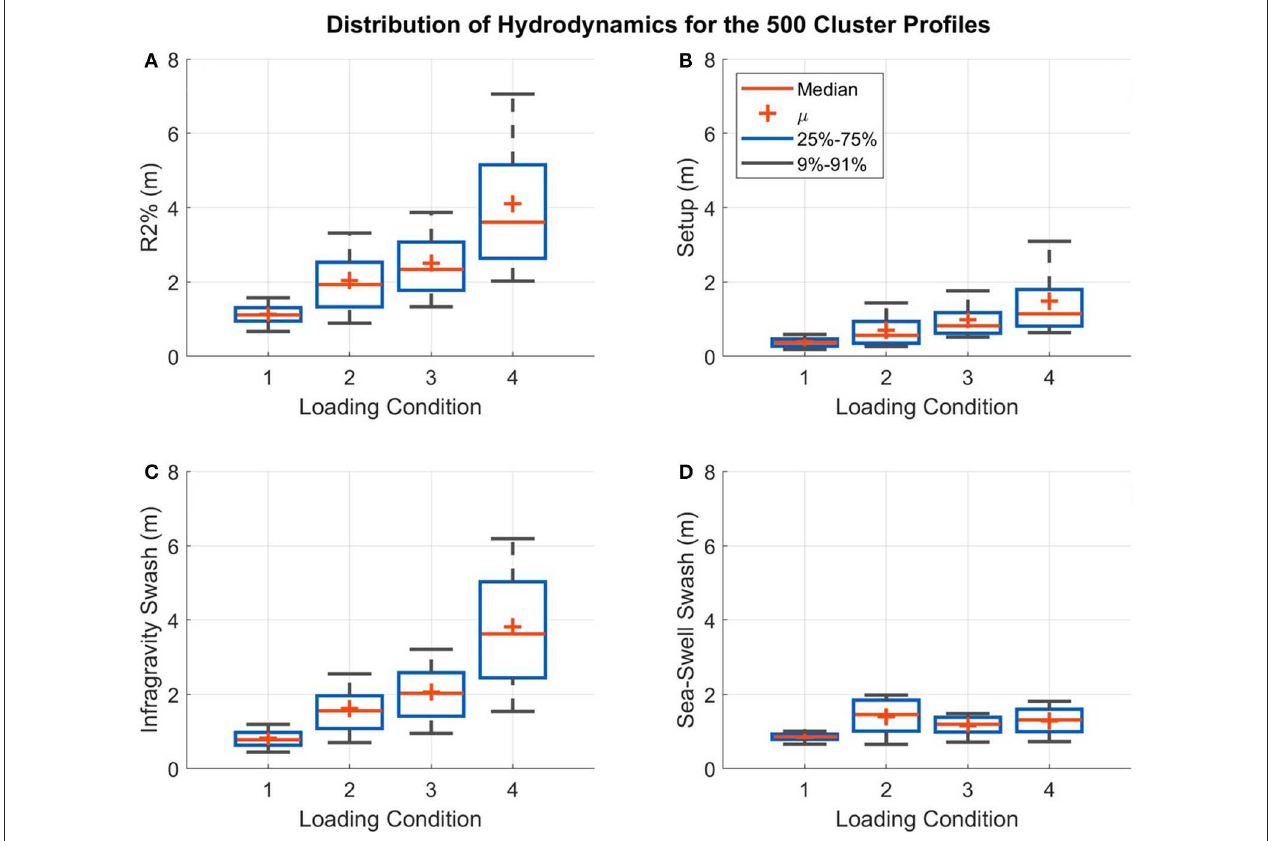
FIGURE 7 | Distributions of the results of the XBeach Non-Hydrostatic (XBNH) runs for the 500 initial representative cluster profiles (iRCPs), including the R 2 % (A) , setup at the shoreline (B) , infragravity (C) , and sea-swell swash (D) . The loading condition numbers along the x-axis correspond to the numbering in Table 2